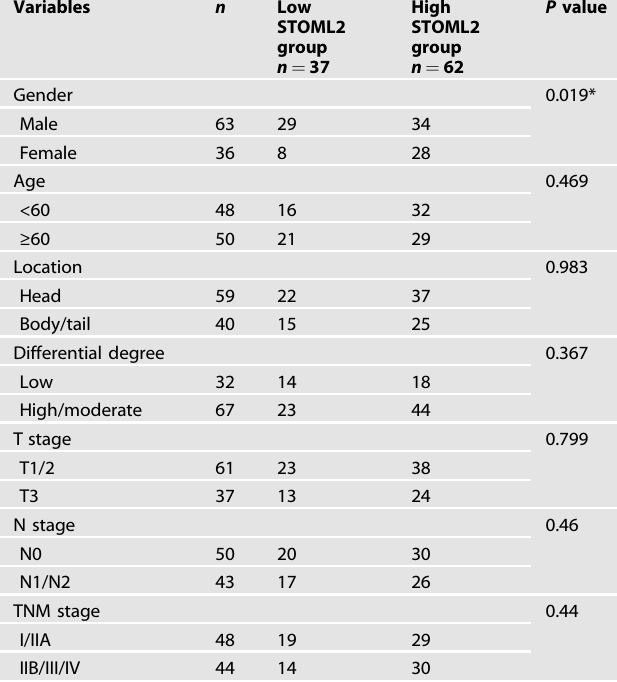
Fig. 1 STOML2 was highly expressed in pancreatic cancer tissue but contributed to prolonged survival. A Expression levels of STOML2 mRNA in normal pancreas and pancreatic cancer tissue. Data were derived from TCGA and GTEx. B IHC scores of STOML2 protein in paired pancreatic cancer tissue and adjacent normal pancreas. C Representative IHC results of pancreatic cancer tissue and normal pancreas from tissue microarray (TMA). Scale bar equals 100 μ m. D Overall survival of low and high STOML2 mRNA groups in TCGA. E Overall survival of low and high STOML2 protein groups in the TMA. ***: P < 0.001. Table 1. Correlations of STOML2 expression levels with clinical and pathologic